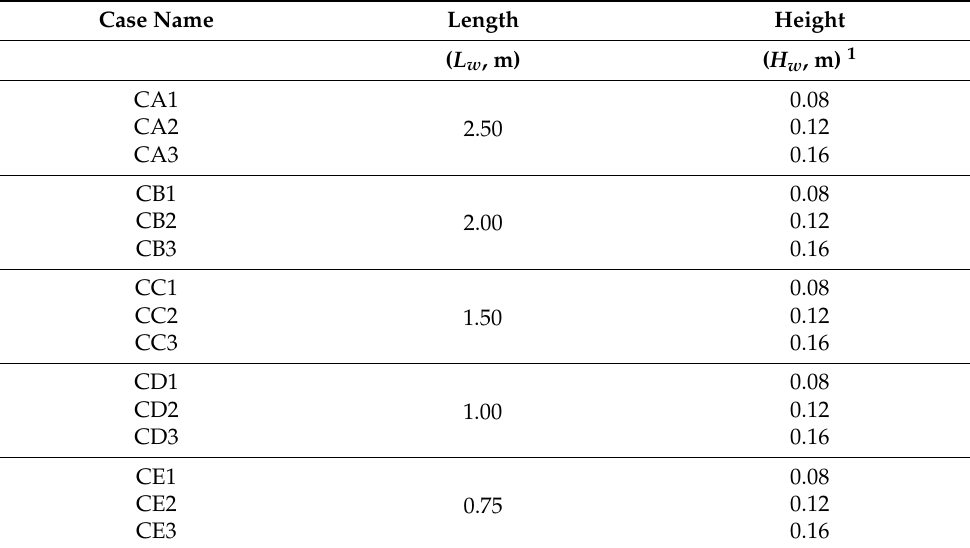
Table 1. Design regular wave parameters sent to the wavemaker to generate the incident wave trains